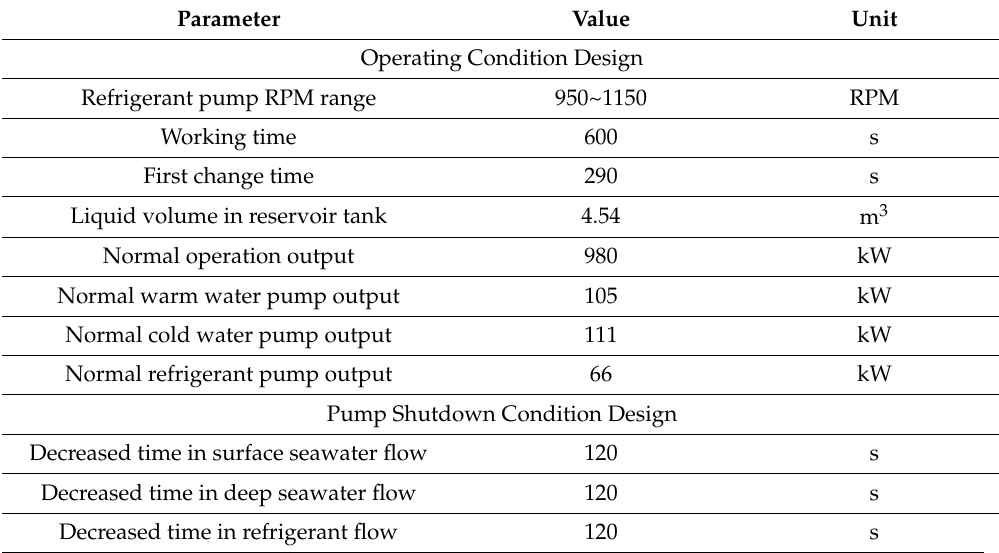
Table 4. Parameter of the dynamic OTEC